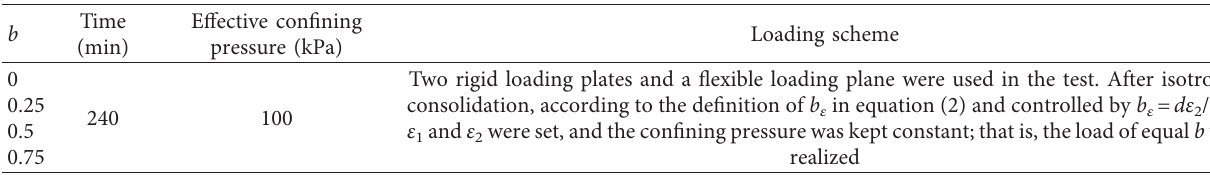
Figure 5: Sample preparation and installation. (a) Specimen preparation member. (b) Table 2: Loading schemes with different b .